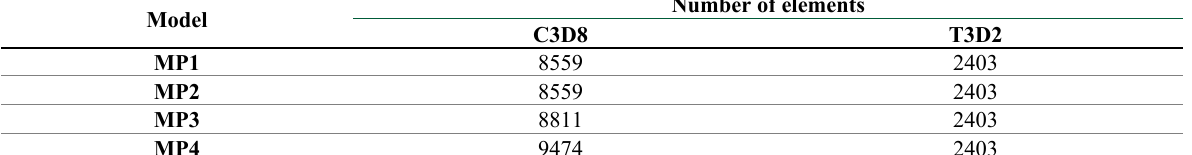
Table 5. Number of finite elements of the numerical models